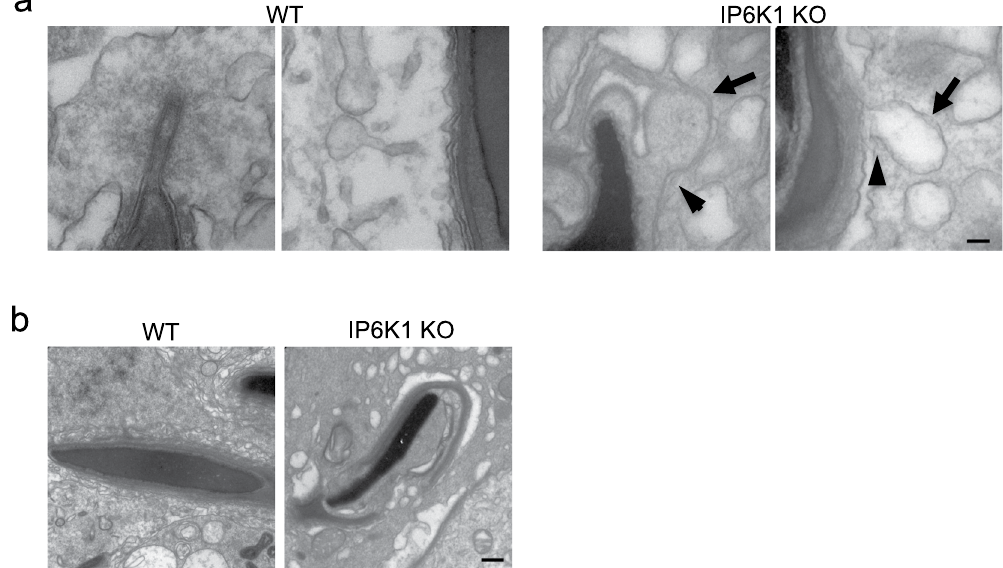
Figure 8. IP6K1 deletion disrupted spermatid-Sertoli cell interactions. ( a ) Electron microscopy showed structures of tubulobulbar complexes of WT and IP6K1 KOs. The bulbs were enlarged (arrows) and the tubular regions were absent (arrowheads) in the IP6K1 KOs. Scale bar 100 nm. ( b ) Electron microscopy showed step 16 spermatids from WT and IP6K1 KO stage VII seminiferous tubules. The KO spermatids showed excess residual cytoplasm and degenerated acrosomes. Scale bar 500